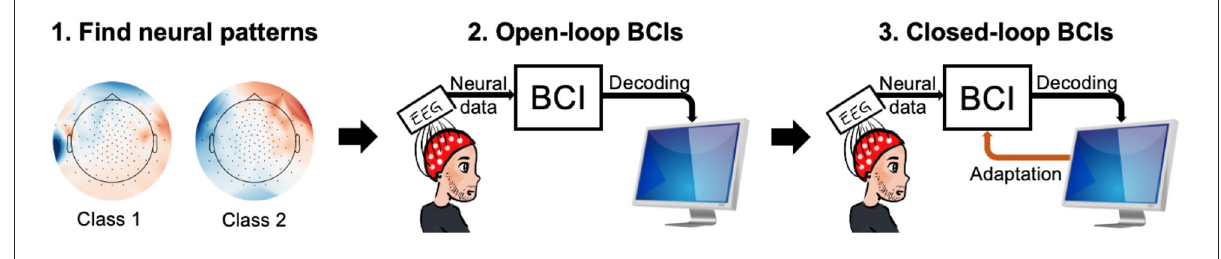
FIGURE1 Stage of development of a